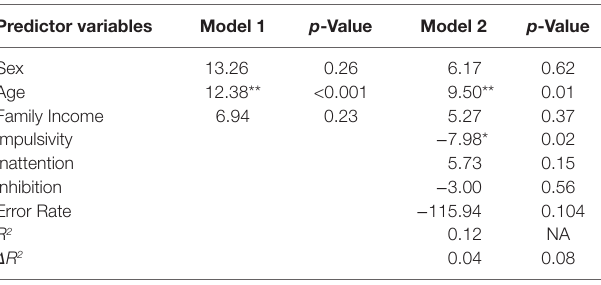
Table 6 | Sequential regression analysis of predictors of language arts scores.